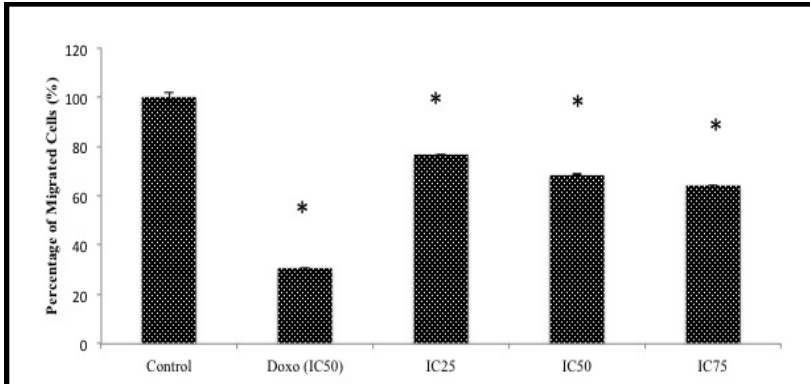
Figure 5. The percentage of migrated cells through the transwell membrane when treated with three different concentrations of BHAQ (IC All data are expressed as mean ± SD. * p < 0.05 compared with corresponding